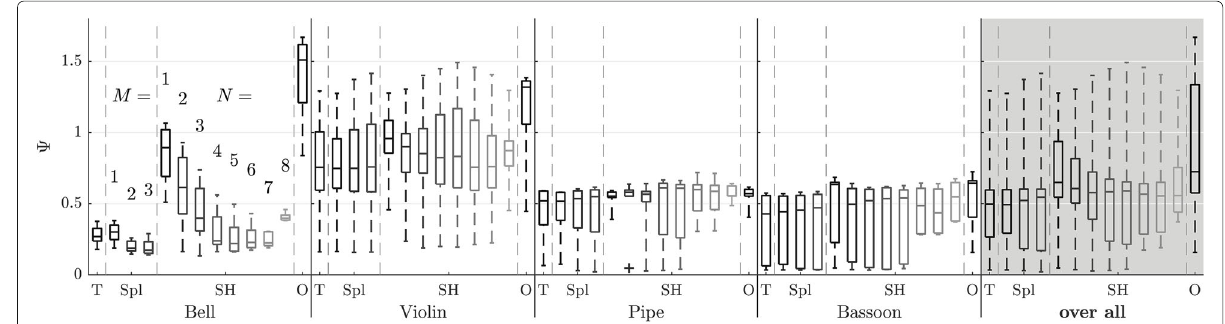
Fig. 5 Distribution of the global error measure (cid:9) for the examined interpolation methods triangular (T), spline (Spl, for M = { 1,2,3 } ), spherical harmonics (SH, for N = { 1,2,...,8 } ), and ordinary omnidirectional assumptions of the directivity (O) for each instrument individually and across all 27 analyzed partial tones. On each box, the central mark indicates the median, and the bottom and top edges of the box show the 25th and 75th percentiles, respectively. The whiskers extend from minimum to